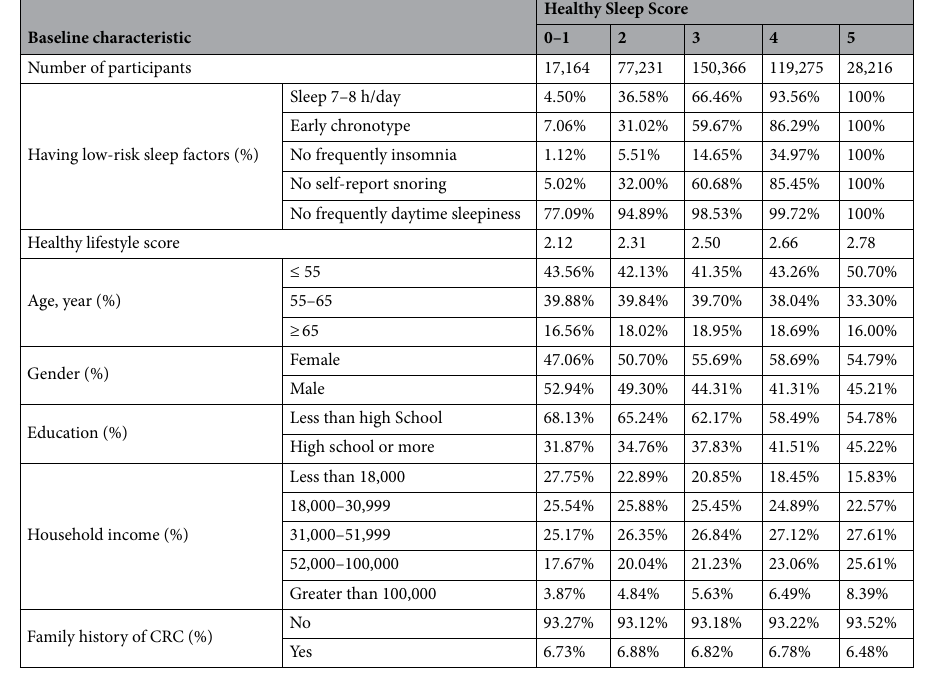
Table 1. Baseline characteristics of participants according to the healthy sleep score. The results are presented as means (continuous variable) and percentage (category variable) according to healthy sleep score.